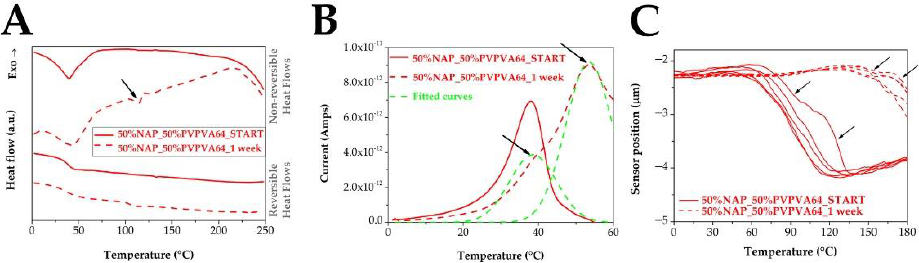
Figure 11. In-depth investigation of the DSC thermograms ( A ), the depolarization current peaks ( B ), and the ramps measured by µ TA ( C ) of the 50% API containing ASDs before and after 1 week of storage. (Black arrows indicate signs of phase separation and crystallization).